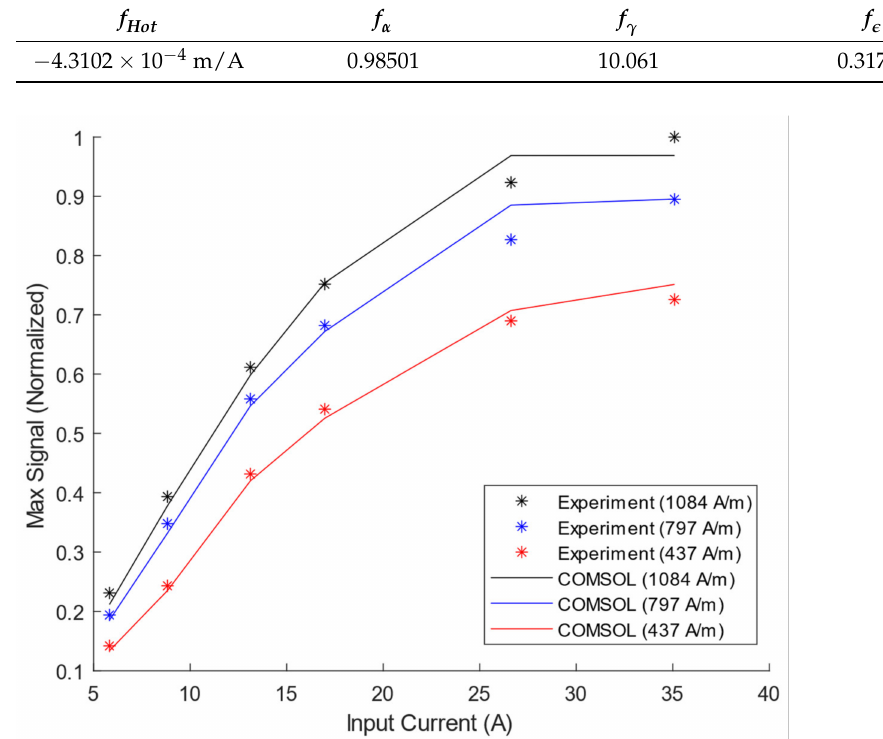
Figure 13. Simulated and Experimental MS-to-PPM Maximum Receiver Voltage on Steel Plate vs. Input Current for three values of Static